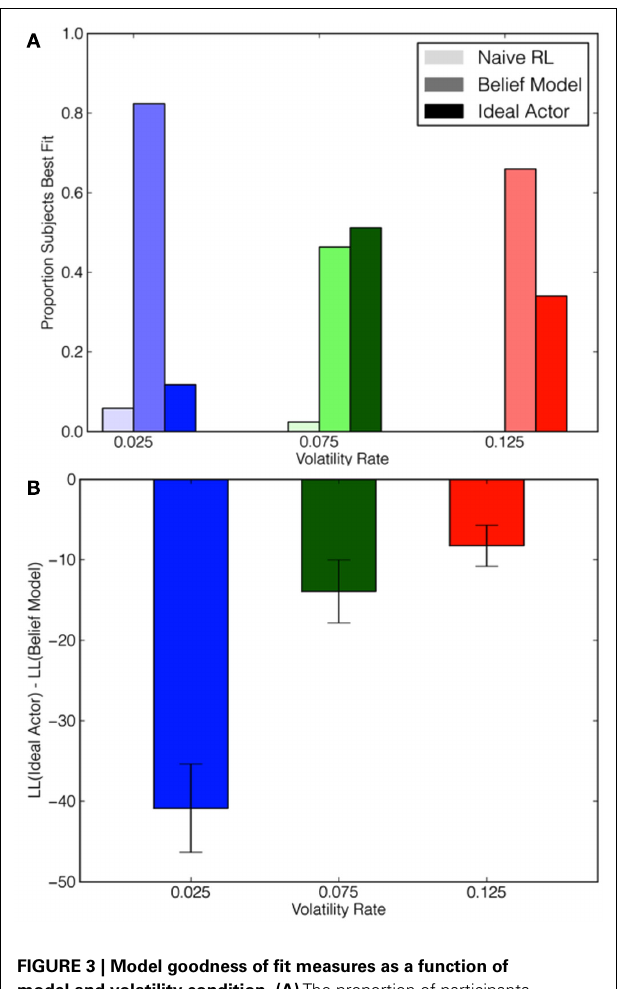
FIGURE 3 | Model goodness of fit measures as a function of model and volatility condition. (A) The proportion of participants that were best fit by each model in each condition. (B) Log-likelihood ratios comparing the Ideal Actor and the Belief model. Negative values indicate that participants were better described by the Belief